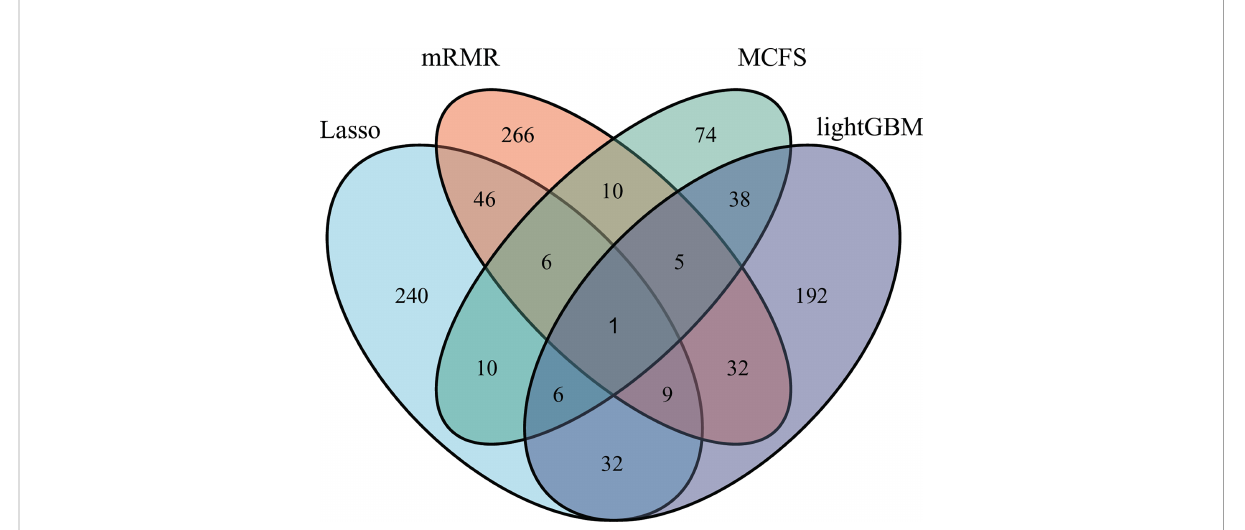
FIGURE 9 Venn diagram to show the intersection of key features identi fi ed by different feature selection methods. Lasso, mRMR, MCFS and LightGBM indicate the feature subsets identi fi ed by the feature selection methods with the same